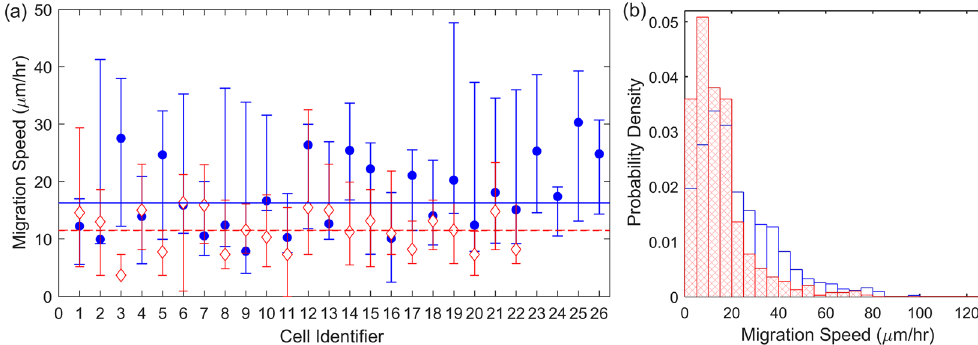
Figure 4. ( a ) The median migration speed of the individual hESCs in the absence (filled blue circles) and presence of Cell Tracer (open red diamonds). The minimum number of measurements for each cell is 8. Error bars correspond to the upper and lower quartiles. The median migration speeds across all cells, are shown by the blue solid line and red dashed, respectively. Cells are ordered by time to division/death, as per Fig. 1. ( b ) Normalised histogram (probability density) of instantaneous migration speeds for cells in absence (blue) and presence of Cell Tracer (red,